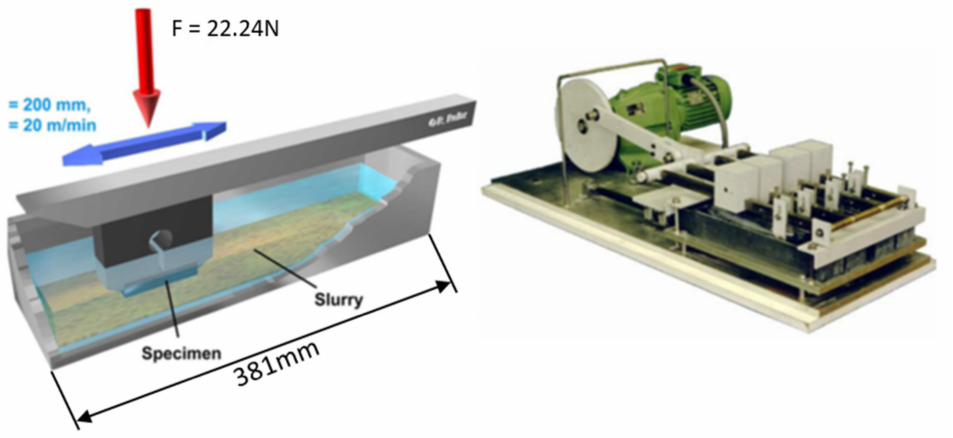
Figure 3. ASTM G75 (Miller Test)